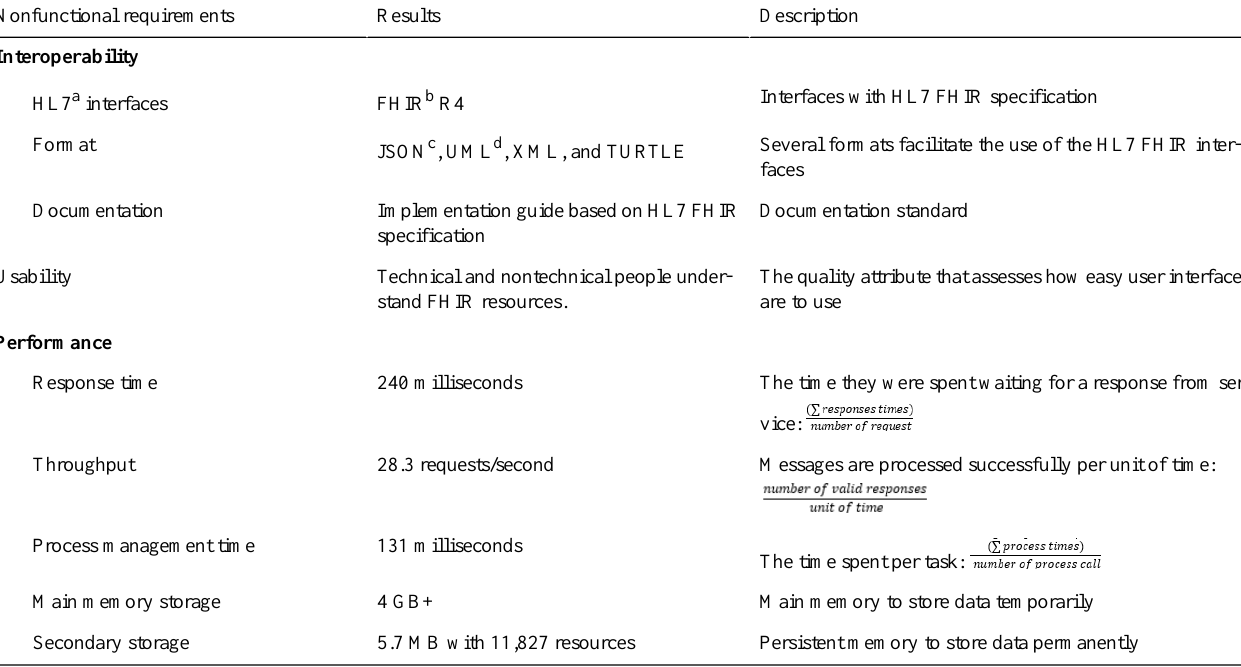
Table 4. The result of testing the nonfunctional requirements. Each nonfunctional requirement was tested. DescriptionResultsNonfunctional